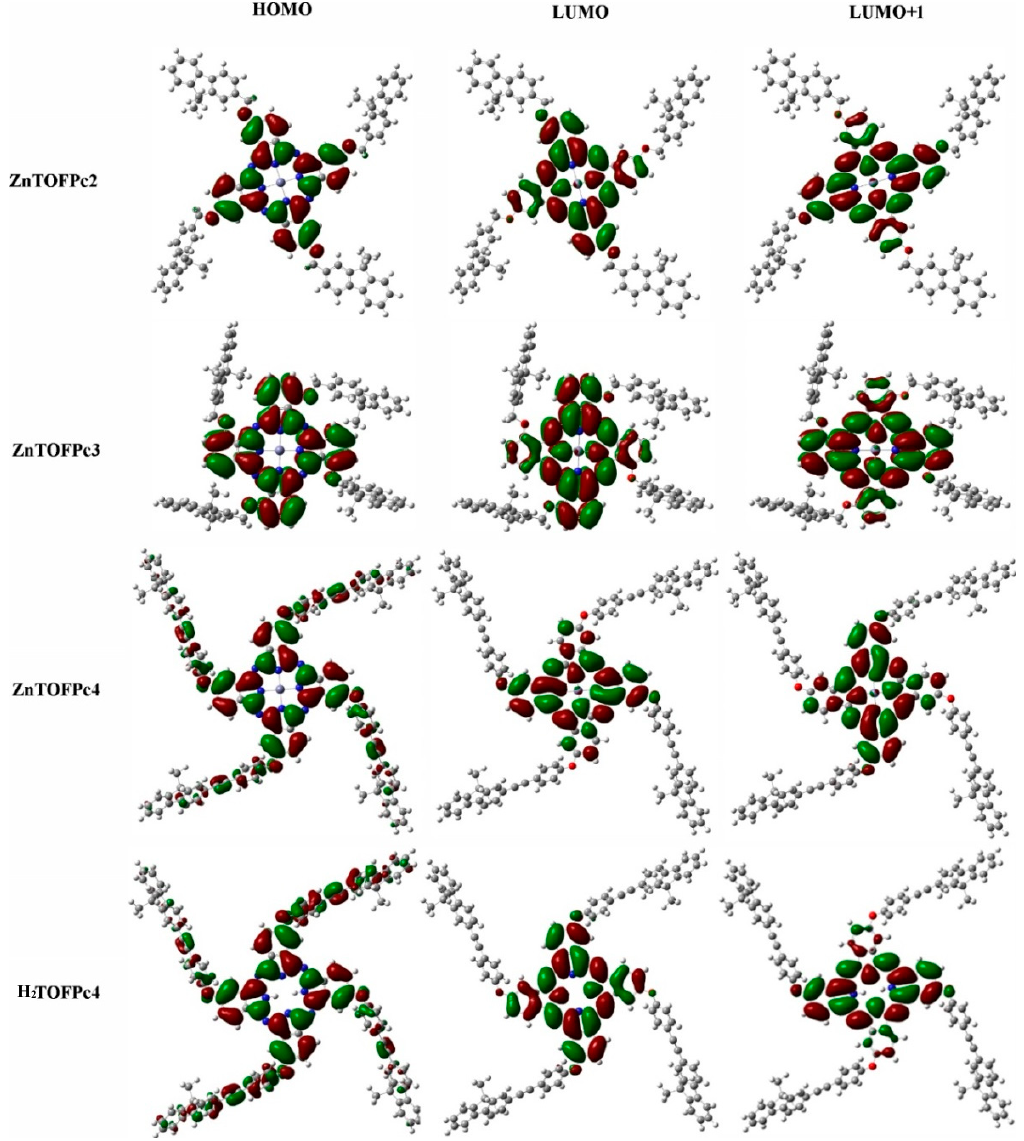
Figure 10. Frontier molecular orbitals of the four model compounds (left: highest occupied molecular orbital (HOMO), middle: lowest unoccupied molecular orbital (LUMO), right: LUMO + 1), shown with an isovalue of 0.01 [e bohr − 3 ] 1/2.